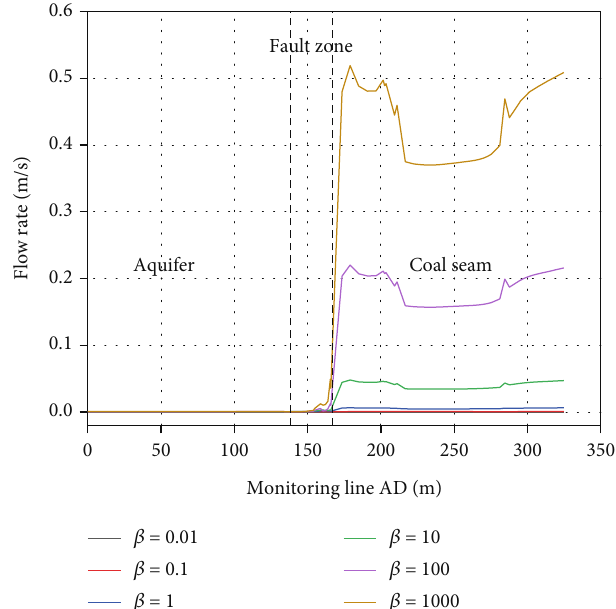
Figure 5: The velocity at each position on the A-D segment.